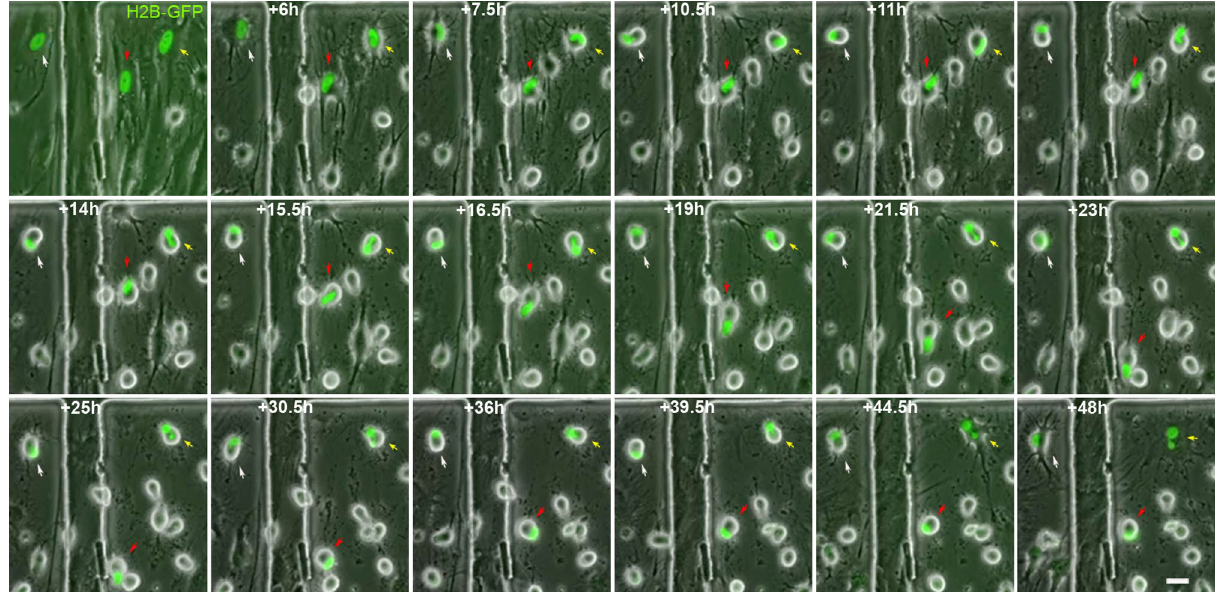
Figure 4. Nucleus remodelling occurs during neural-like differentiation from hBM-MSCs. Time-lapse microscopy evidenced that nuclear remodelling occurred during neural-like differentiation from histone H2B- GFP-expressing hBM-MSCs. Nuclei from hBM-MSC-derived intermediate cells moved within the cell, adopting different morphologies, including finger shaped (red arrows) and kidney shaped (white arrows), and even forming lobed nuclei connected by nucleoplasmic bridges (yellow arrows). Scale bar: 25